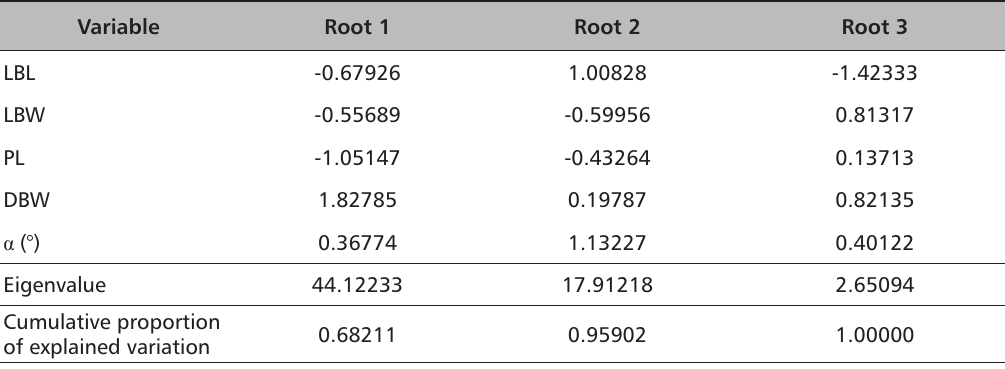
taBle 8. Standardised coefficients for canonical variables